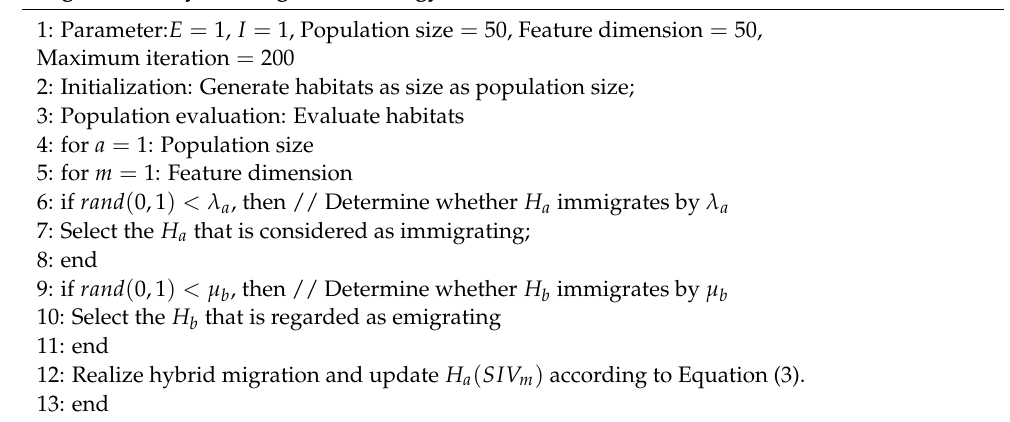
Algorithm 1 Hybrid Migration